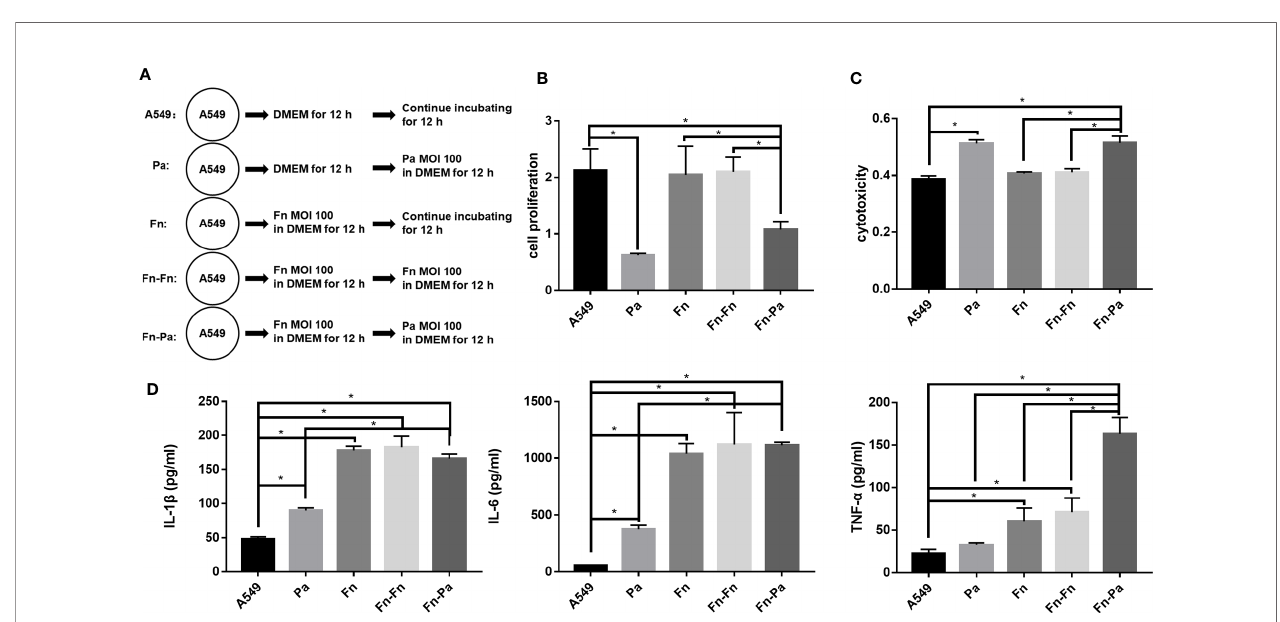
FIGURE 6 | The effect of F. nucleatum pretreatment on cellular proliferation, cytotoxicity and in fl ammation. (A) Schematic representation of cell assay. A549 cells cultured in DMEM for 24 h were the blank control. Pa represented A549 cells precultured in DMEM for 12 h followed by P. aeruginosa (MOI 100) infection for other 12 h. Fn represented A549 cells treated with F. nucleatum (MOI 100) for 24 h. Fn-Fn means that A549 cells pretreated with F. nucleatum (MOI 100) for 12 h continue to be infected with another F. nucleatum (MOI 100) for 12 h. Fn-Pa means that A549 cells pretreated with F. nucleatum (MOI 100) for 12 h continue to be infected with P. aeruginosa (MOI 100) for 12 h. (B) The effect of F. nucleatum pretreatment on cellular proliferation of pulmonary epithelial cells. (C) The effect of F. nucleatum pretreatment on cytotoxicity of pulmonary epithelial cells. (D) The effect of F. nucleatum pretreatment on IL-1 b , IL-6 and TNF- a productions of pulmonary epithelial cells. * P < 0.05, statistics were achieved by analysis of variance followed by Sidak ’ s multiple comparisons test.